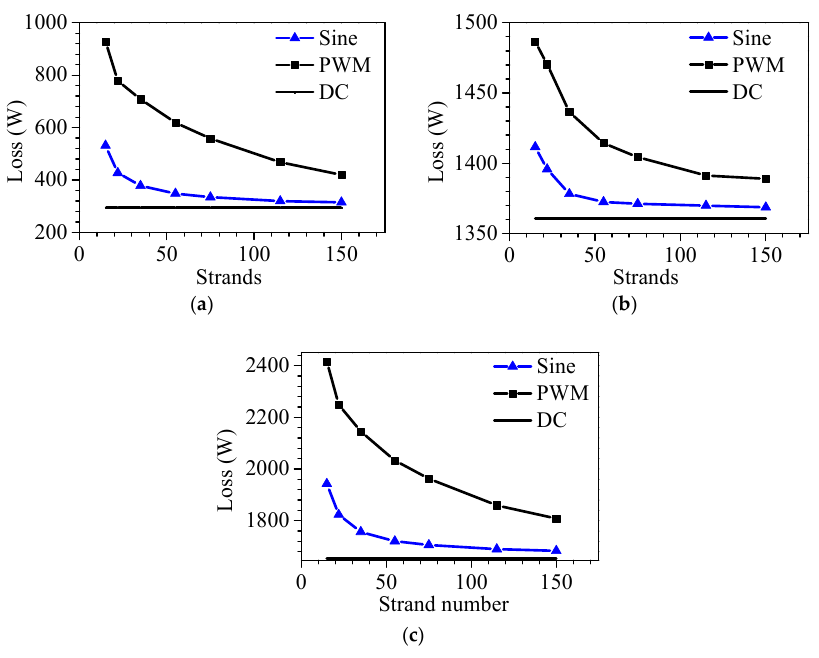
Figure 9. Influences of the strand number of conductors on ( a ) inner-slot-windings loss; ( b ) end- windings loss; ( c ) total copper loss, under sine voltage and 8 k carrier-frequency PWM excitations, compared with DC loss as well.